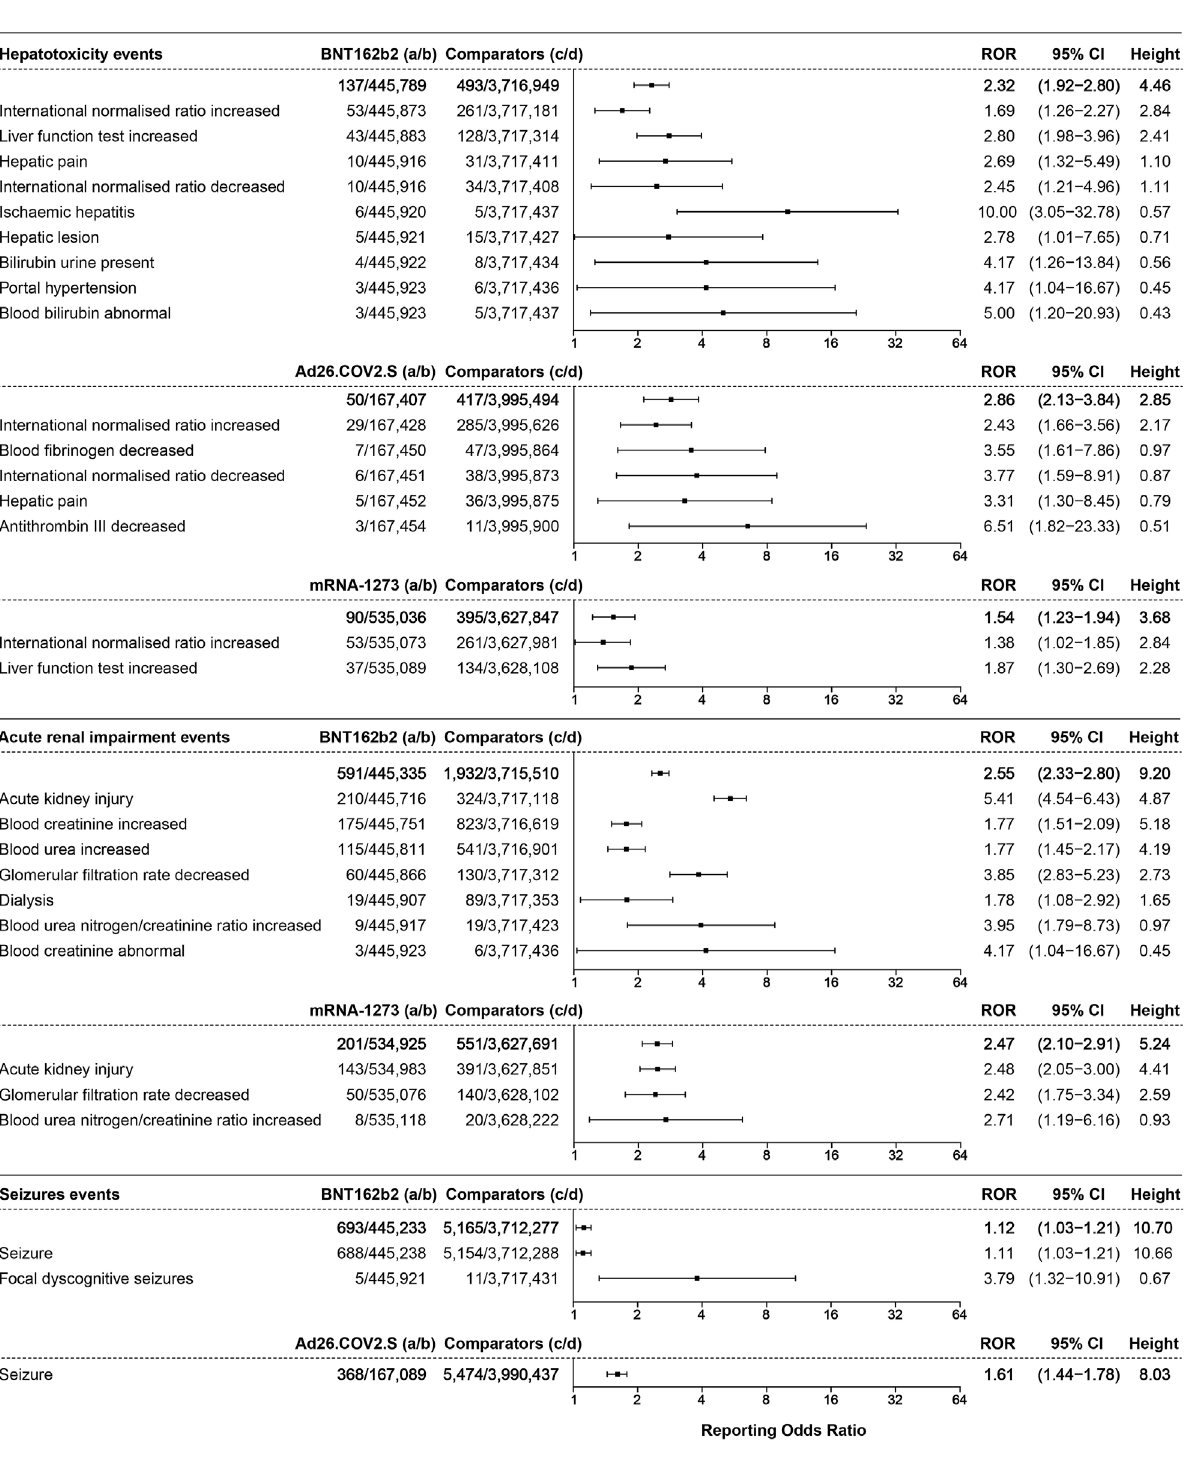
FIGURE 7 The ROR values and height of the COVID-19 vaccines of BNT162b2-, Ad26.COV2.S-, and mRNA-1273-associated hepatotoxicity, acute renal impairment,andseizureevents.a:casesoftargethepatotoxicity,acuterenalimpairment,andseizureeventsreportedconcerningthetargetCOVID- 19 vaccines; b: cases of other adverse events reported concerning the target COVID-19 vaccines; c: cases of target hepatotoxicity, acute renal impairment, and seizure events reported concerning all the other vaccines; d: cases of other adverse events reported concerning all the other